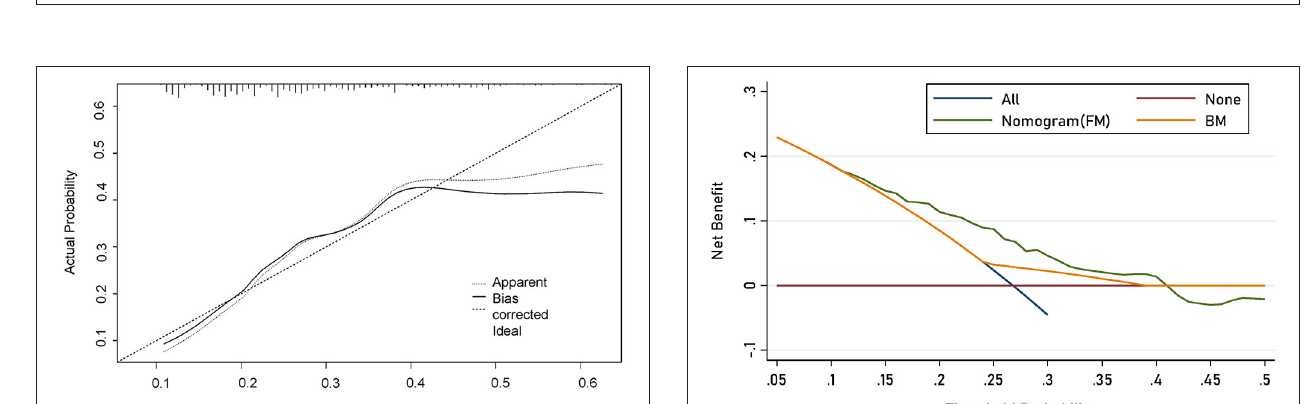
FIGURE 2 | The prediction nomograms of risk factors for SA in MDD patients.